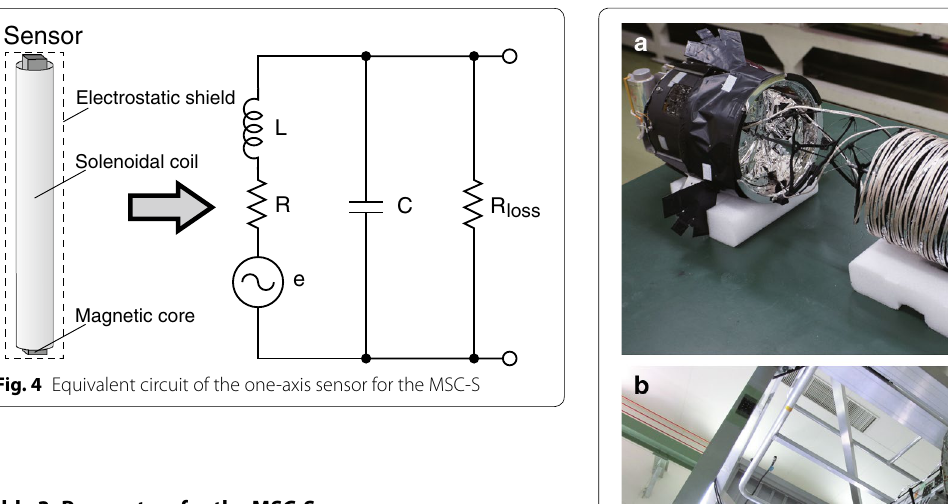
Table 3 Parameters for the MSC-S